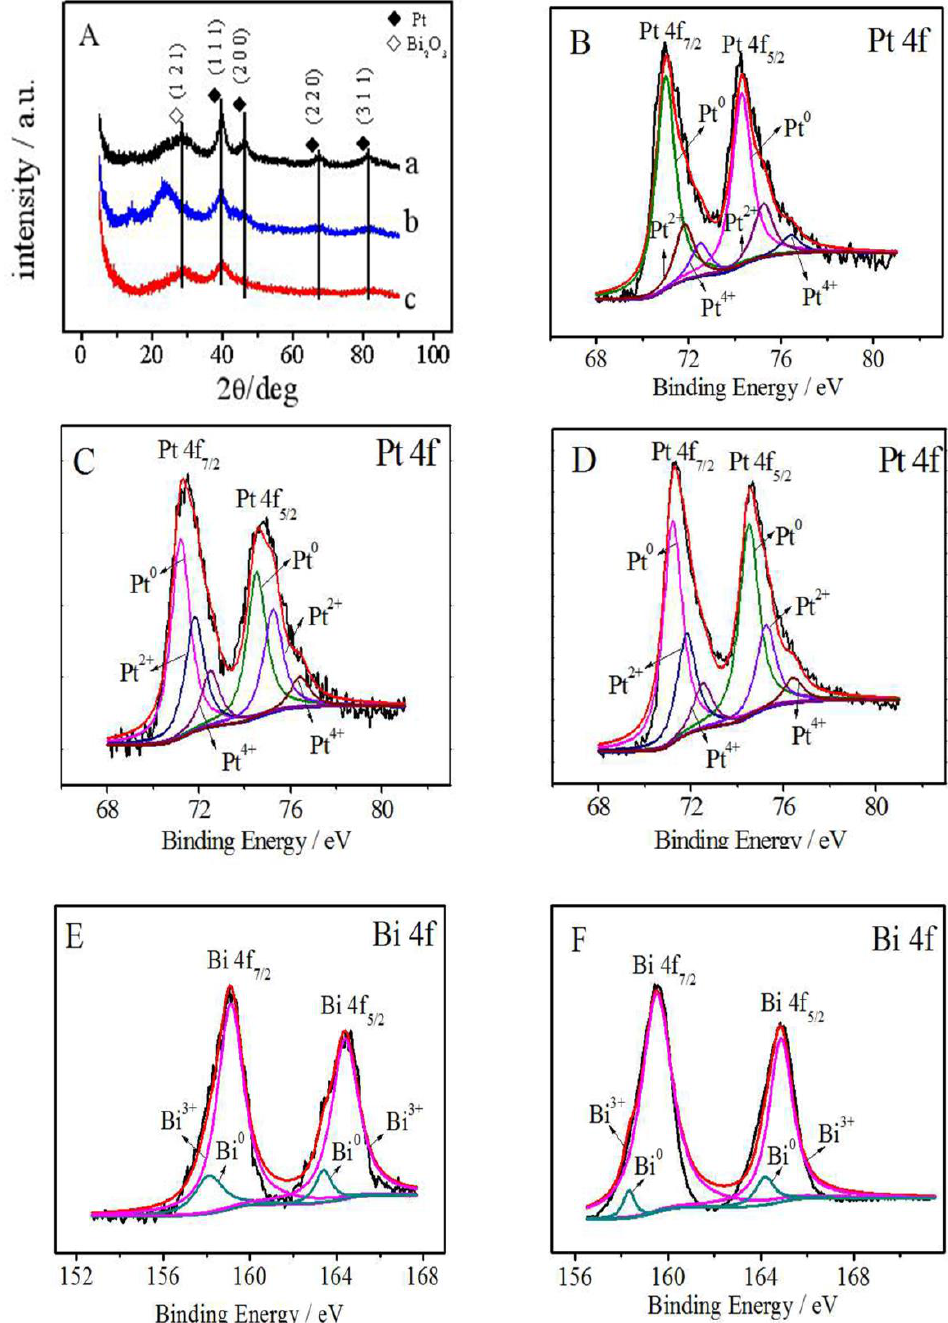
Figure 1. ( A ) X-ray diffraction (XRD) patterns: Pt-Bi (Bi 2 O 3 )/GNs (PVP) ( a ), Pt/GNs (PVP) ( b ), and Pt-Bi (Bi 2 O 3 )/GNs ( c ); ( B ) Pt 4f X-ray photoelectron spectroscopy (XPS) for Pt-Bi (Bi 2 O 3 )/GNs (PVP);